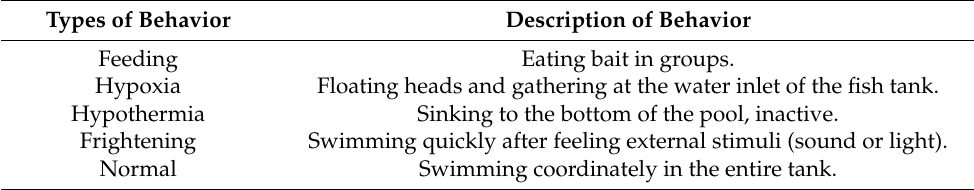
Table 1. Description of fish behavior based on video analysis.